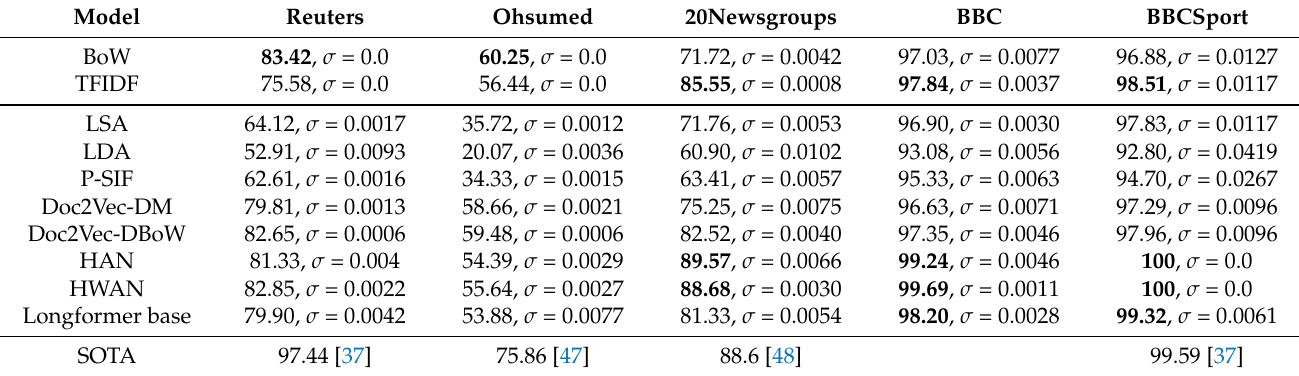
Table 5. Averaged overall classification accuracy (in percent); cross-validation for Ohsumed, BBC and BBCSport, test-train split for Reuters and 20Newsgroups. The maximum length of input data for HAN and HWAN was set at 30 utterances 300 words each. Numbers in bold denotes results better than BoW and TFIDF or the best